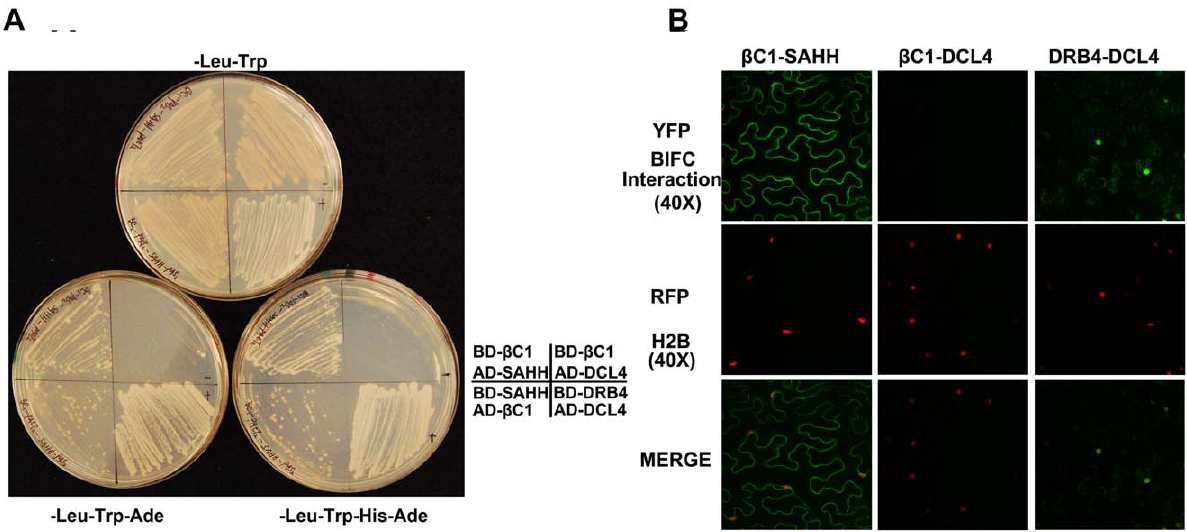
Figure 6. b C1 protein interacts with SAHH. (A) Yeast two-hybrid interaction. Bait proteins were expressed as GAL4 DNA binding domain fusions, and prey proteins as GAL4 activation domain fusions, in yeast PJ649A cells. Growth on media lacking leucine (-Leu) and tryptophan (-Trp) indicates maintenance of the bait and prey plasmids. Interaction is indicated by growth on plates also lacking adenine (-Ade), or histidine and adenine (-His- Ade). (B) BiFC interaction. Constructs expressing b C1 and SAHH fused to the N- or C-terminal portions of YFP were delivered to N. benthamiana leaf cells by agroinfiltration. Cells were photographed 48 hours post-infiltration at 40 X magnification using a confocal laser scanning microscope. RFP- histone 2B (RFP-H2B) was used as a marker for the nucleus. The co-expressed proteins are indicated above the photographs, which are representative of results with all possible combinations of fusion proteins. In both yeast two-hybrid and BiFC experiments, DRB4 was co-expressed with DCL4 as a positive control, and b C1 was expressed with DCL4 as a negative